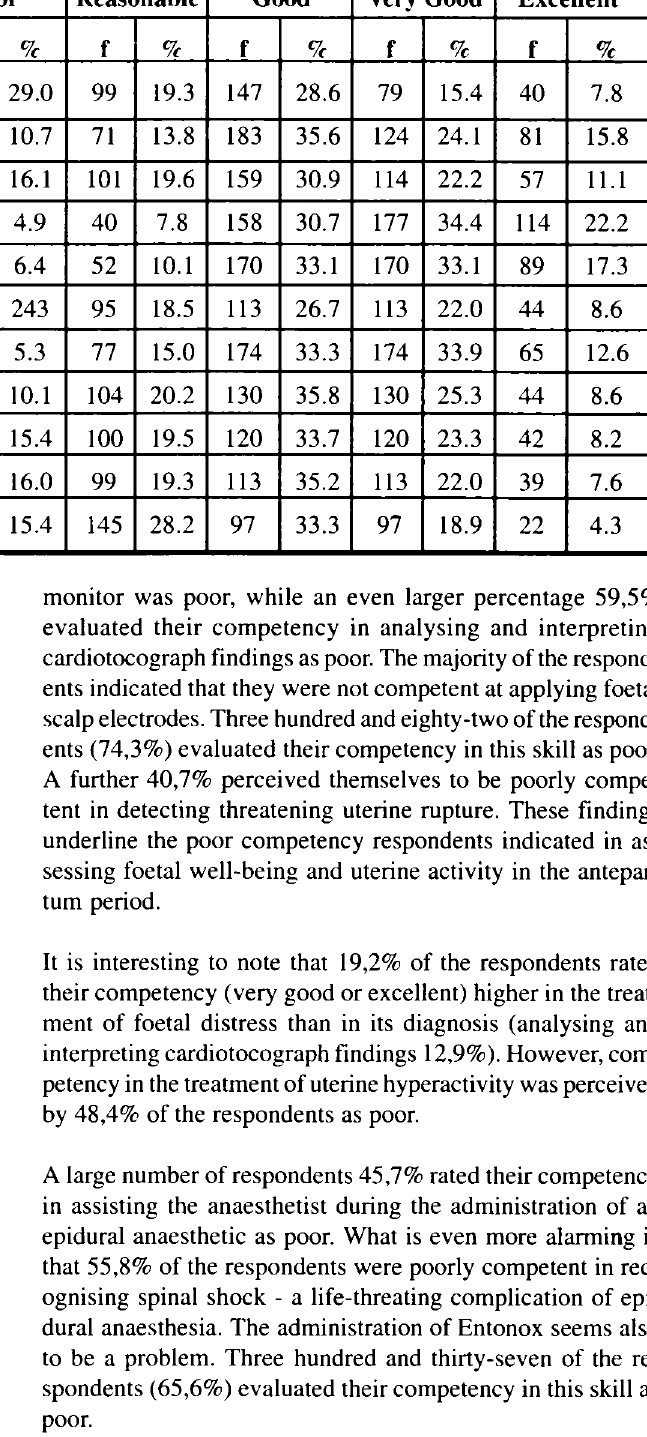
TABLE 5: Self-perceived competency: Postnatal nursing care POSTNATAL NURSING CARE